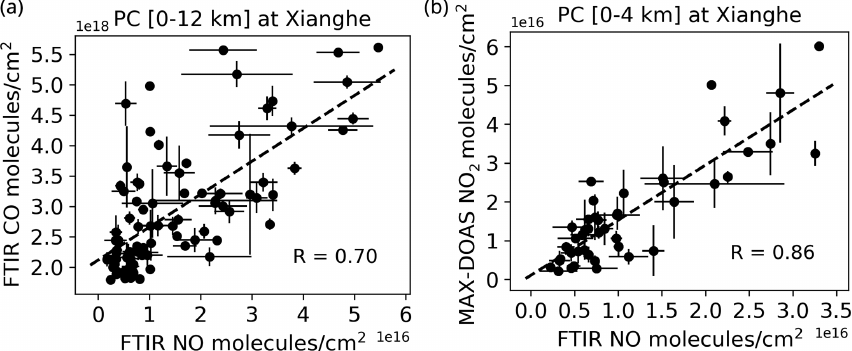
Figure 12. (a) The correlation between the daily means of the FTIR-retrieved NO tropospheric partial columns and the retrieved CO tro- pospheric partial columns in winter at Xianghe. (b) The correlation between the daily means of the FTIR-retrieved NO partial columns and MAX-DOAS-retrieved NO 2 partial columns between the surface and 4km at Xianghe. The error bar is the daily SD, and the dashed black line is the linear